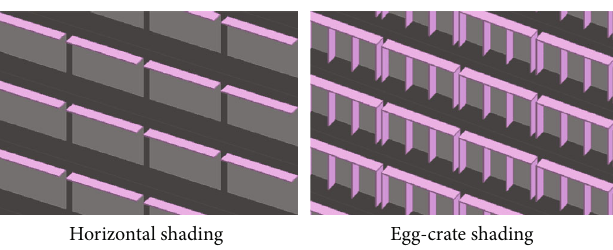
(Figure 18). Three sizes were used (0.3m, 0.6 m, and